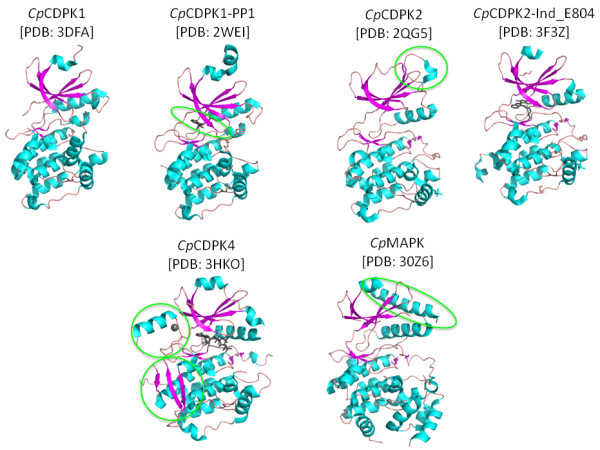
Overall structures of CpCDPK enzymes. The green circles highlight important features within the structures. In the CpCDPK1 structure, the binding of the PP1 inhibitor is shown. The α-helix D orientation is highlighted in the apo CpCDPK2 structure. For the CpCDPK4 structure, the Zn-finger and β-mesh position are shown. In the CpMAP-1 structure, the unusually long α-L16 helix is shown.